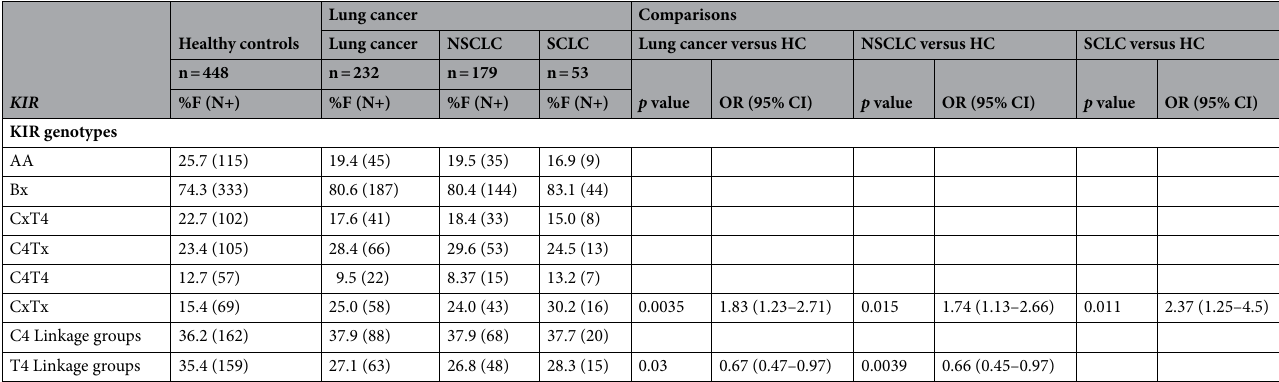
Table 4. KIR genotype frequencies among patients with lung cancer and healthy controls. N + number of individuals positive for the gene, n number of individuals tested for the gene, HC healthy control, OR odds ratio, CI confidence interval. p < 0.05: statistically significant; based on two-tailed Fisher’s exact test.